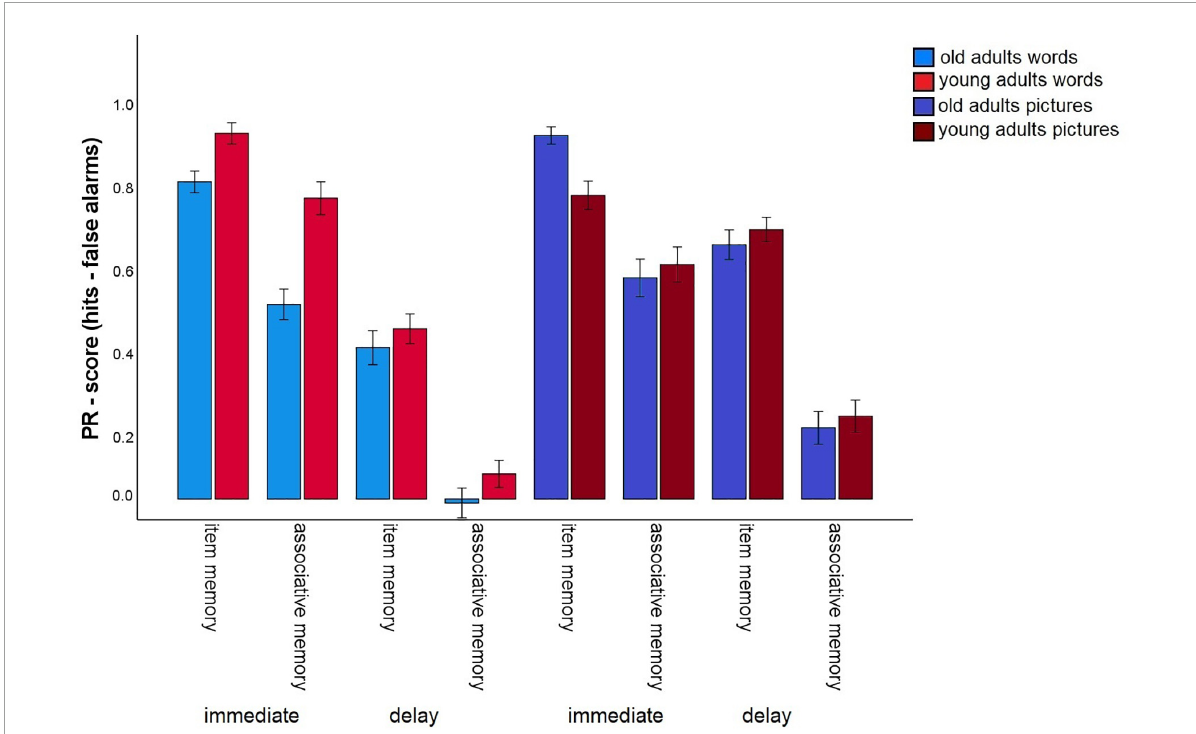
FIGURE6 Pr-Scores of item memory and associative memory for immediate (average task 1–3) and delayed retrieval, separated for younger and older subjects, and for words and pictures. Error bars represent the standard error of the